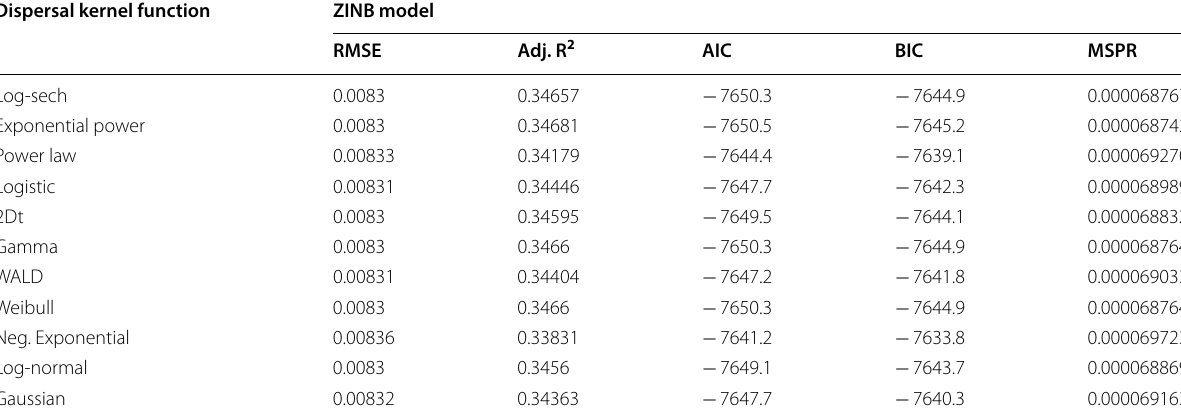
RMSE: root mean square error; adj. R 2 : adjusted coefficient of determination; AIC: Akaike’s information criterion; BIC: Schwarz’s Bayesian information criterion; MSPR: mean squared prediction error